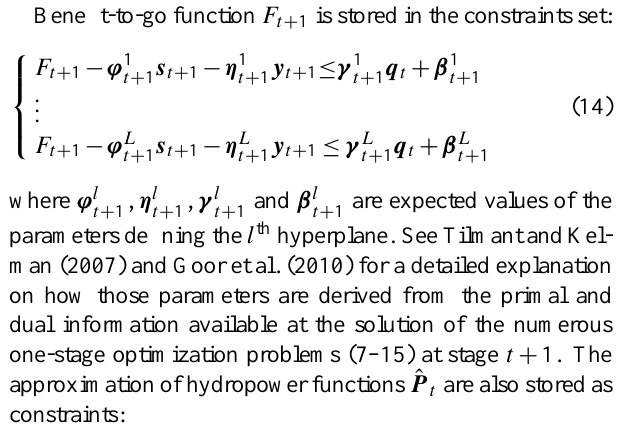
Fig. 1. Naturalized discharge of the Nile at key locations in the Nile Basin (period 1954–2000).